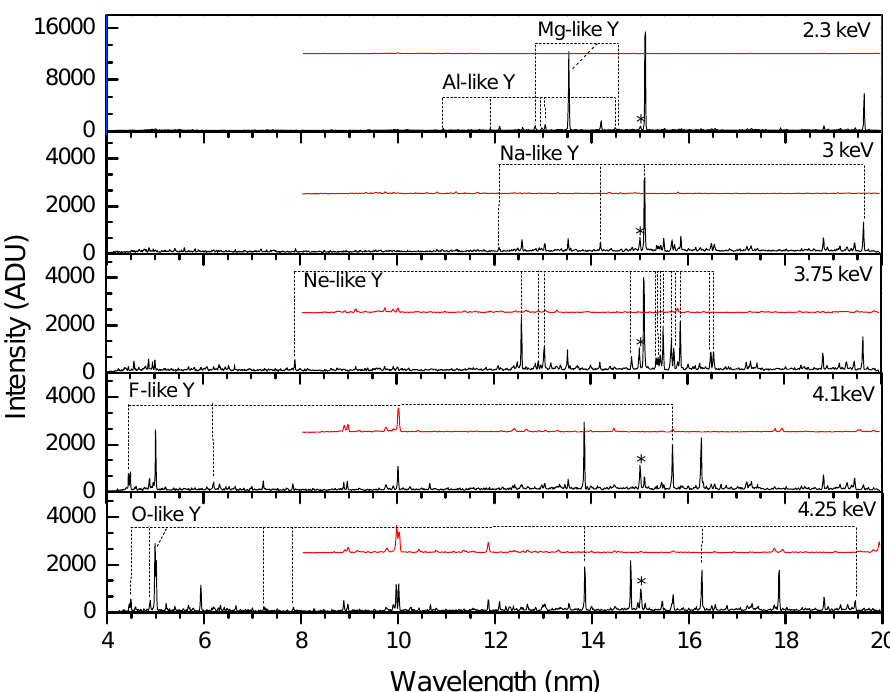
Figure 4. Yttrium spectra at beam energies from 2.30 keV–4.25 keV. The black and red (shifted) spectra correspond to the first and second order Y spectra, respectively. The ∗ marks the impurity coming from oxygen at 15.0099(5) nm.